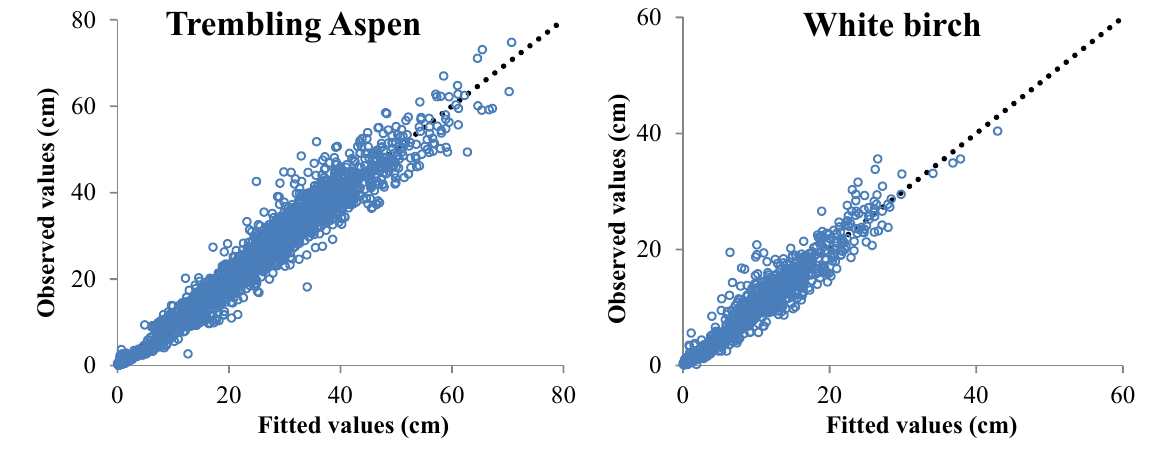
Figure 2. Plots of predicted stem diameter against the observed stem diameter. For trembling aspen and white birch predictions are based on Equation (13); and for balsam fir, lodgepole pine, black spruce and white spruce on Equation (15), as described in Section